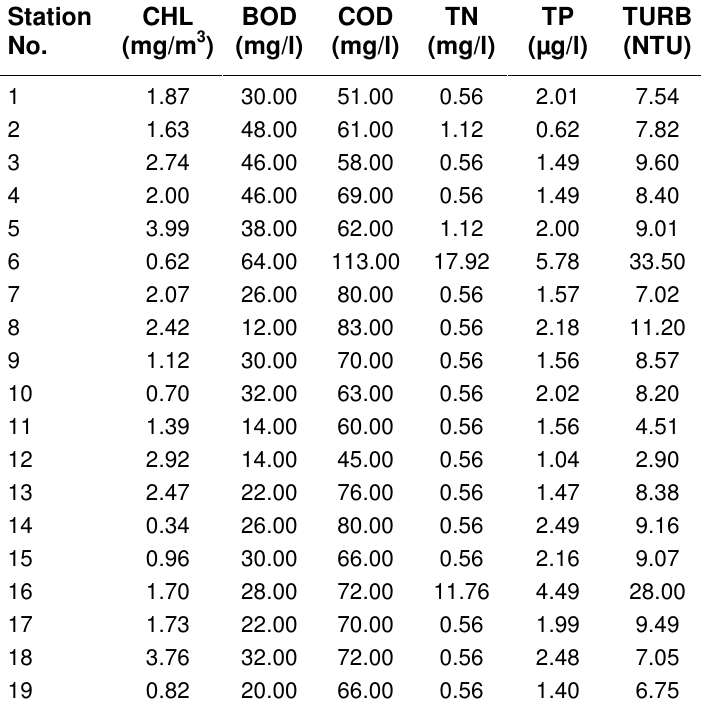
WQ Parameters Measured at